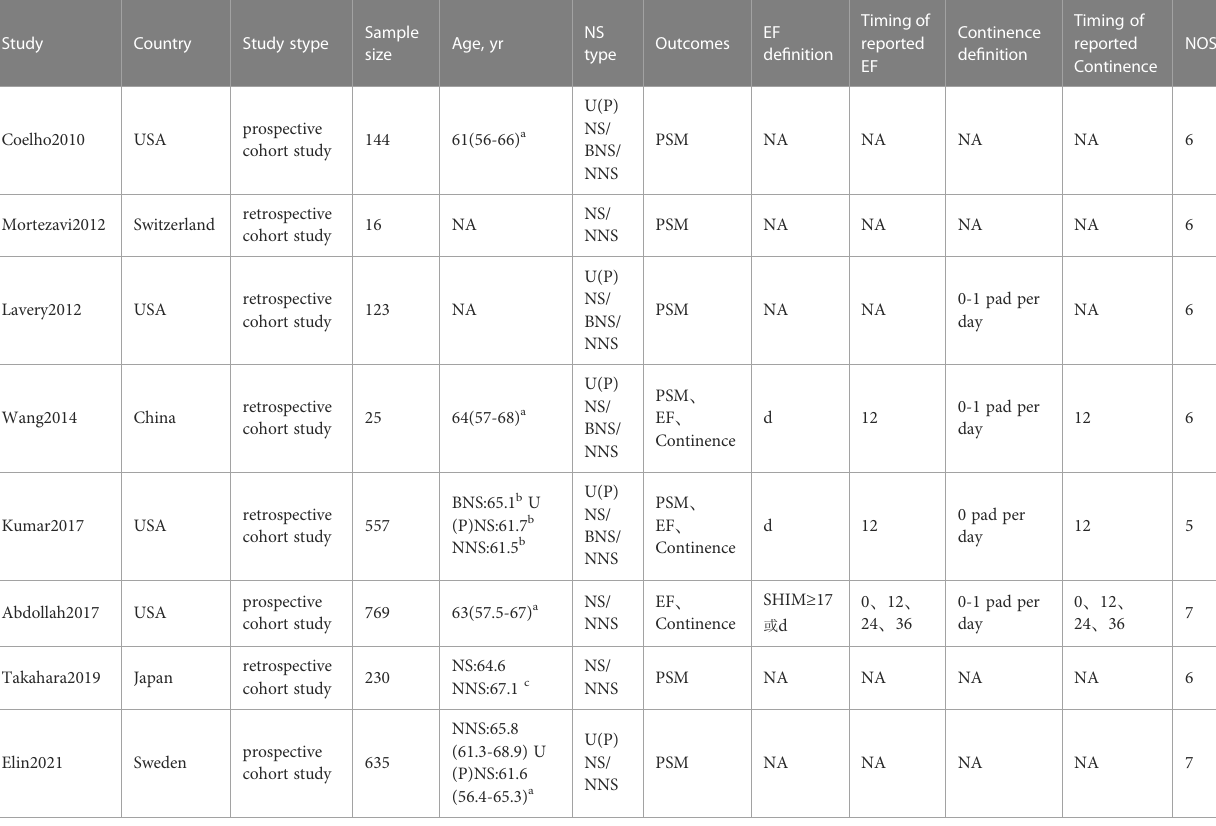
TABLE 1 Characteristics of included